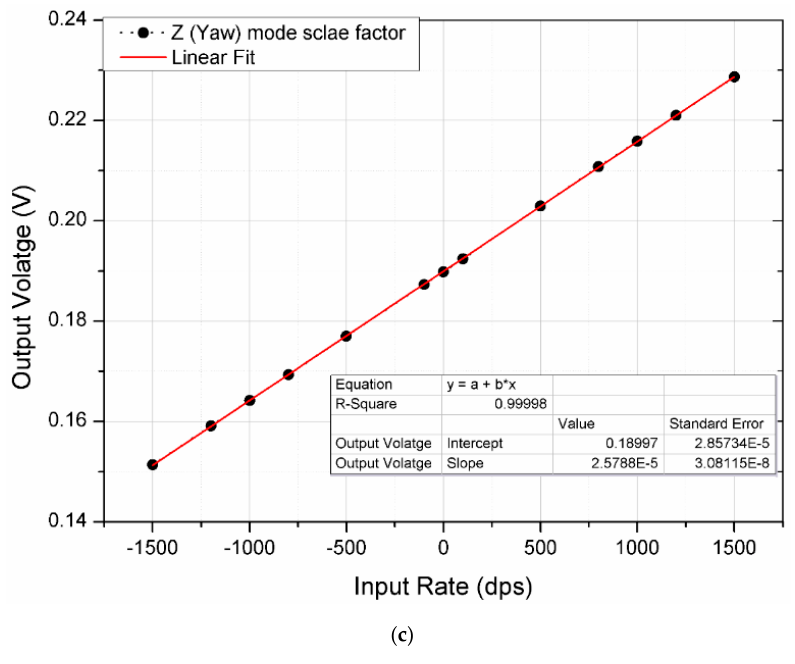
Figure 9. DC response of the multi ‐ axis gyroscope ( a ) Roll. ( b ) Pitch. ( c ) Yaw.